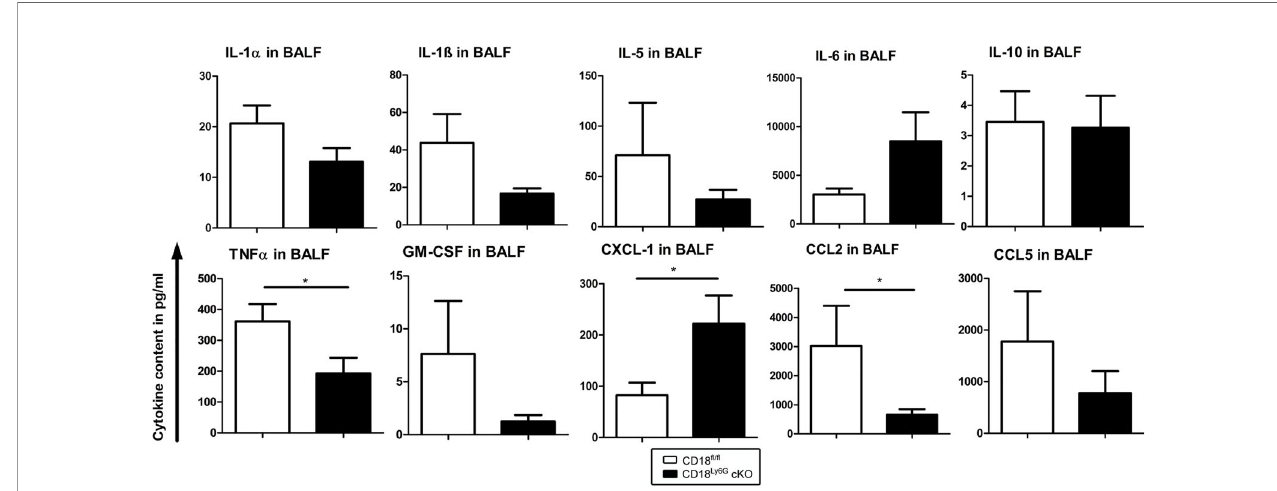
FIGURE 4 | The BAL fl uid of A. fumigatus infected CD18 Ly6G cKO mice contains lower levels of proin fl ammatory cytokines. CD18 fl / fl and CD18 Ly6G cKO mice were infected i.t. with A. fumigatus . On the next day, mice were euthanized, and cytokines in BAL fl uid were analyzed. Data denote the mean ± SEM of 6-10 samples analyzed per group. Statistically signi fi cant differences between groups are indicated (* p <